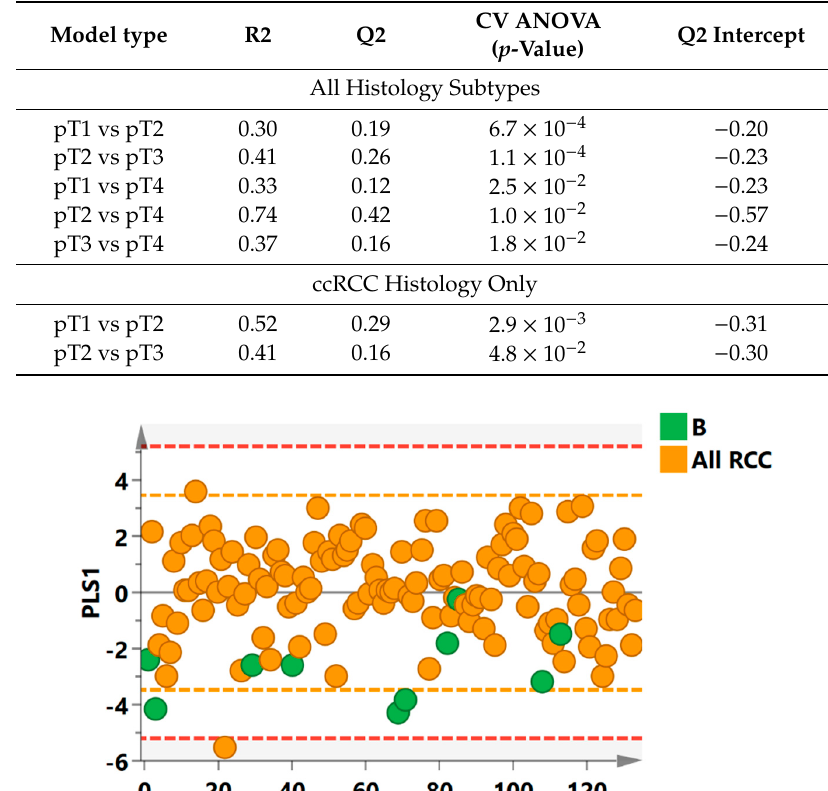
Table A1. Statistical metrics of group separation between RCC stages of all histology subtypes and between RCC stages of ccRCC histology subtype from orthogonal partial least squares discriminant analysis (OPLS-DA) models.